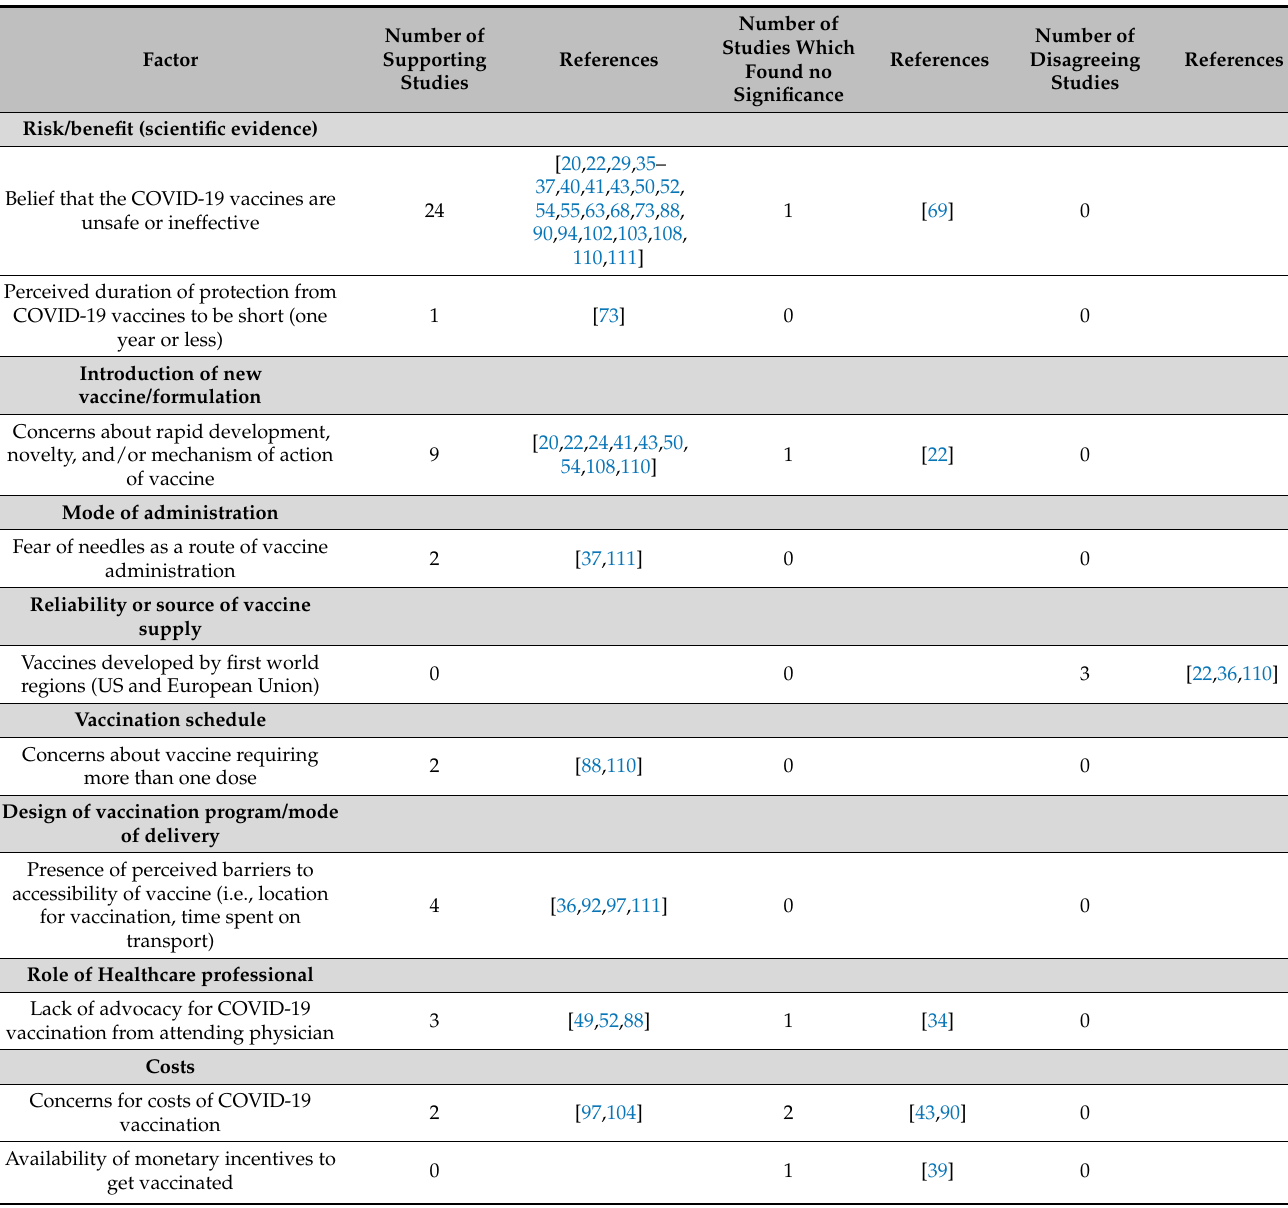
Table 4. Vaccine related determinants of vaccine hesitancy in high-income countries or regions.